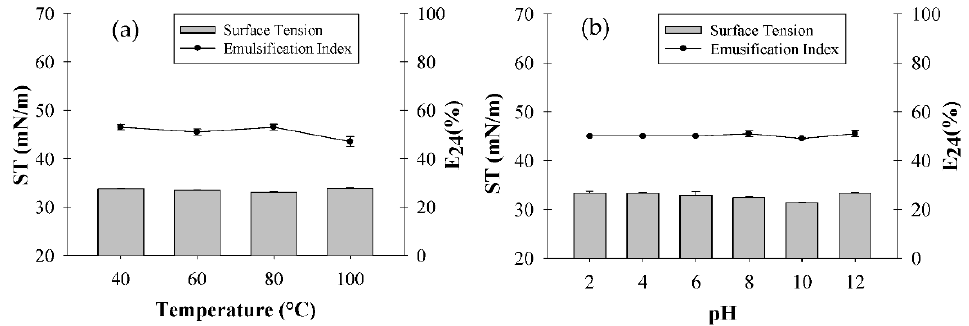
Figure 3. Influence of temperature ( a ) and pH ( b ) on Malpighia emarginata extract’s surface tension (ST) and emulsification index (E 24 ).